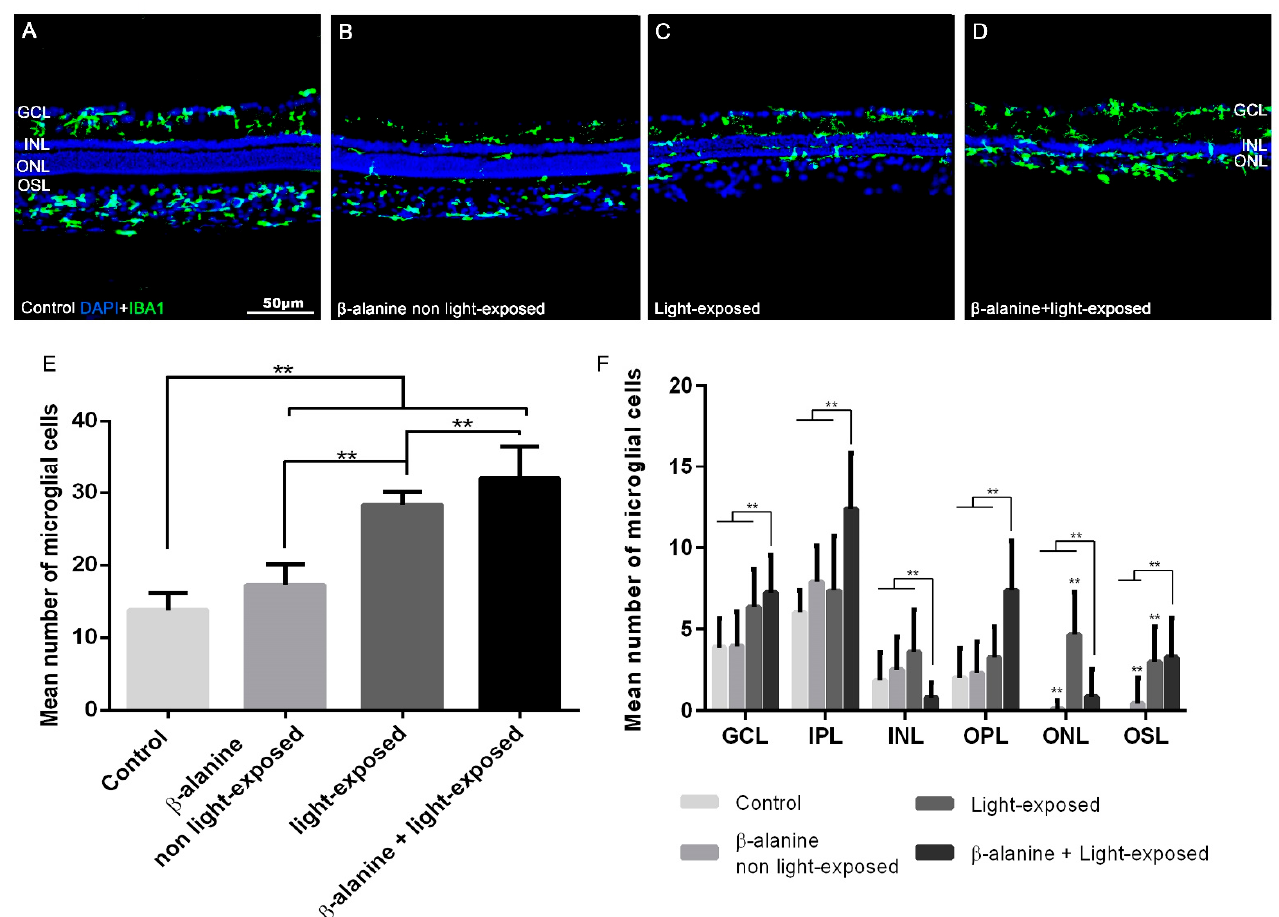
Figure 4. Microglial cell quantification. Upper part: Photomicrographs taken from retinal cross sections of representative animals from the different subgroups: control ( A ), β -alanine non light-exposed ( B ), light-exposed ( C ) and β -alanine and light-exposed ( D ) rats showing microglial cell immunoreactivity (green) and DAPI nuclear counterstaining (blue). Microglial cells can be seen in the outer retinal layers in the retinas of the experimental subgroups ( B – D ). Lower part: Bar graphs showing the mean ± SD numbers of microglial cells per retina ( E ) and per retinal layer ( F ) in the different experimental subgroups. In F, the bar for the control subgroup is missing in the ONL and OSL because the retinas of control animals did not show microglial cells in these layers. Scale bar: 50 µm. n = 10 per subgroup analyzed. In ( E ) we show ** Significant differences between the control subgroup and the experimental subgroups and between the different experimental subgroups. p ≤ 0.001 ( t -test). In ( F ) we show ** Significant differences between the β -alanine and light-exposed subgroup and all the other subgroups in all the retinal layers except in the OSL, where this group showed significant differences only with the β -alanine non-light exposed group and light-exposed group p ≤ 0.001 ( t -test). GCL: Ganglion cell layer. INL: Inner nuclear layer. ONL: Outer nuclear layer. OSL: Outer segments layer. ** p ≤ 0.0001 ( t -test).